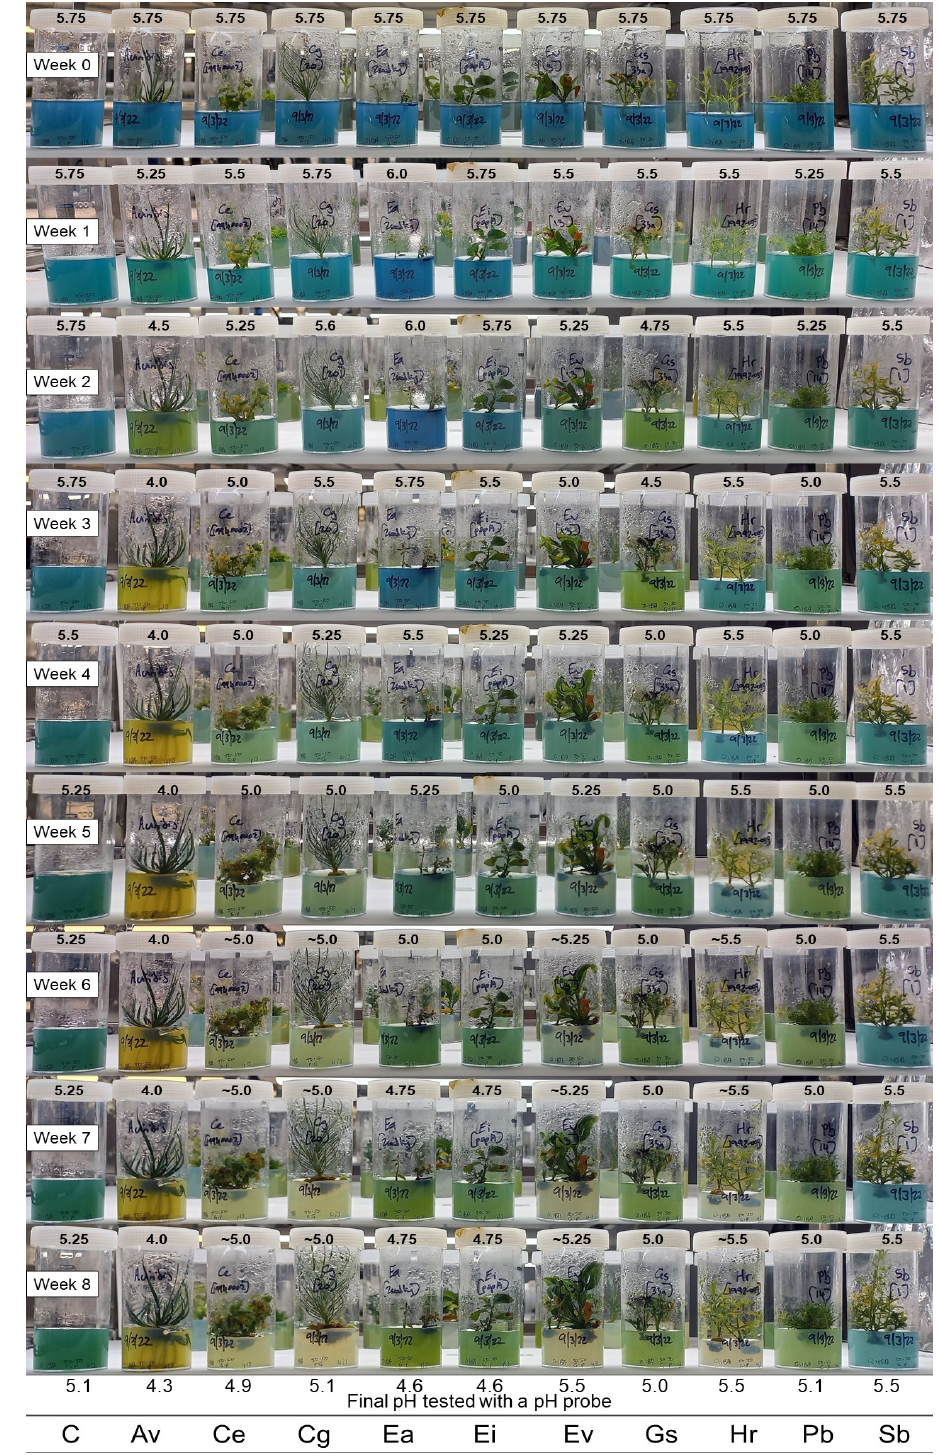
Figure 4. Visual change in pH of the medium with a 1:1 bromocresol green (BCG):bromocresol purple (BCP) combination used at a concentration of 10 µg mL − 1 over an eight week period. Initial pH of the medium was approximately 5.75, visual estimation of pH based on the colour given above each jar. The symbol ~ denotes pH indicator colour fading in medium, making visual pH estimation difficult. Control (C), Anigozanthos viridis (Av), Commersonia erythrogyna (Ce), Conospermum galeatum (Cg), Eucalyptus argutifolia (Ea), Eucalyptus impensa (Ei), Eremophila virens (Ev) , Grevillea scapigera (Gs), Hemiandra rutilans (Hr), Philotheca basistyla (Pb), and Symonanthus bancroftii (Sb).